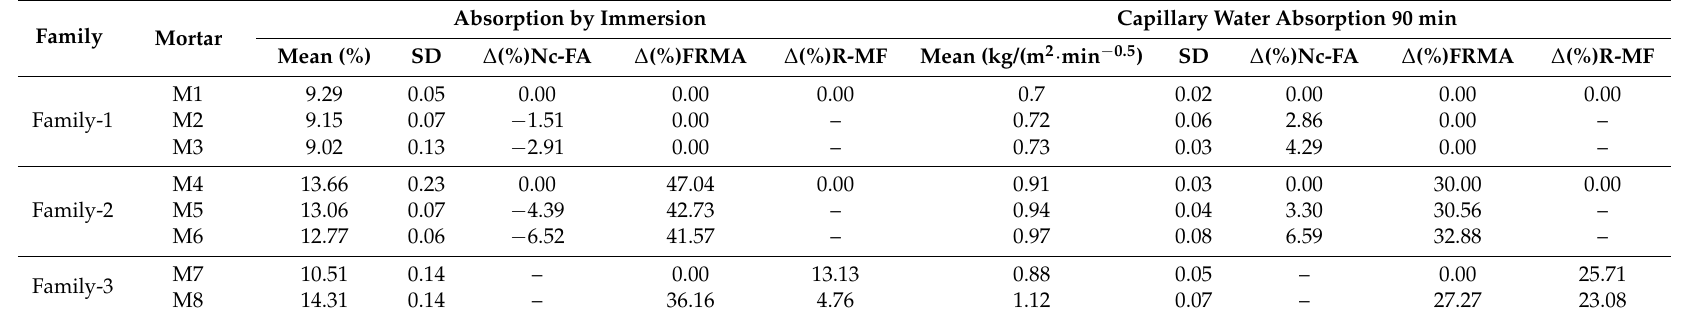
Table 11. Water absorption by immersion and capillary action of hardened